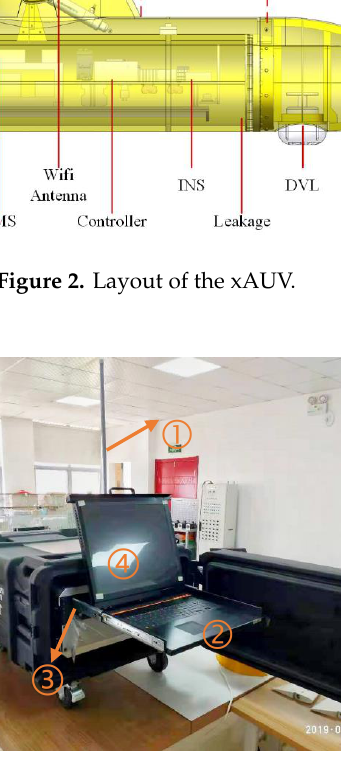
Figure 3 . Surface monitor, including ( 1 ) WIFI antenna; ( 2 ) KVM; ( 3 ) Computer; ( 4 ) Display interface.